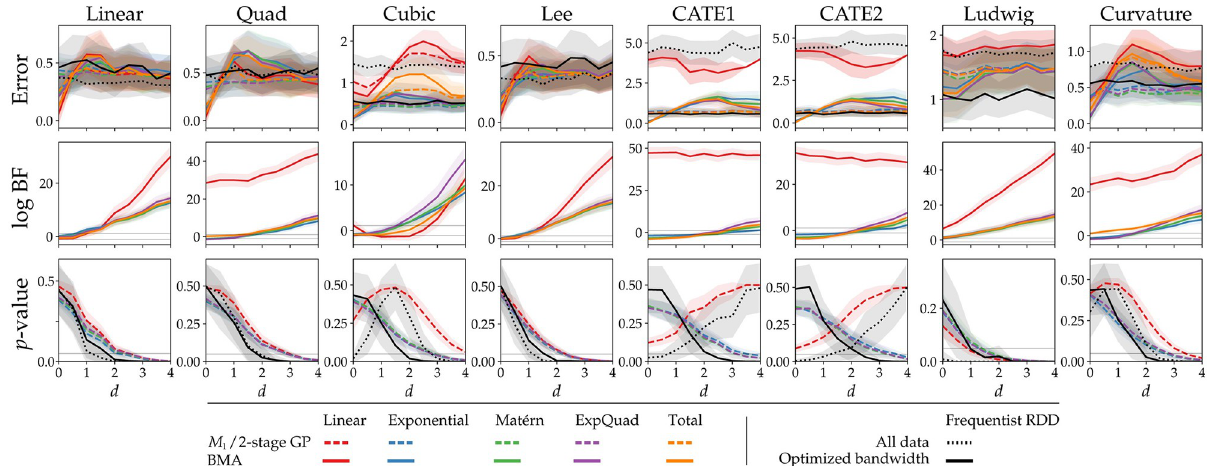
Fig 2. Simulation results. Top row: the error between the true and estimated effect size. The dashed line indicates the 2-stage GP approach (see text), which is equivalent to M . Middle row: The log Bayes factor. Final row: The p -values obtained by the RDD baseline (black) and the 2-stage approach. 1 The horizontal dashed lines indicates the common thresholds of |BF| < 3 and p = 0.05. Error bars indicate standard errors over simulations runs.